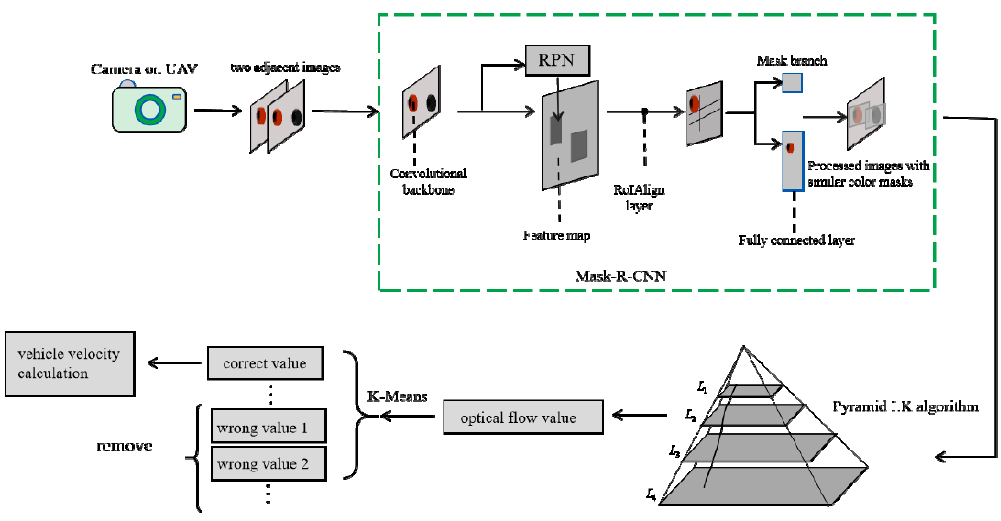
Figure 1. The process of improved algorithm based on Mask-R-CNN and K-Means.